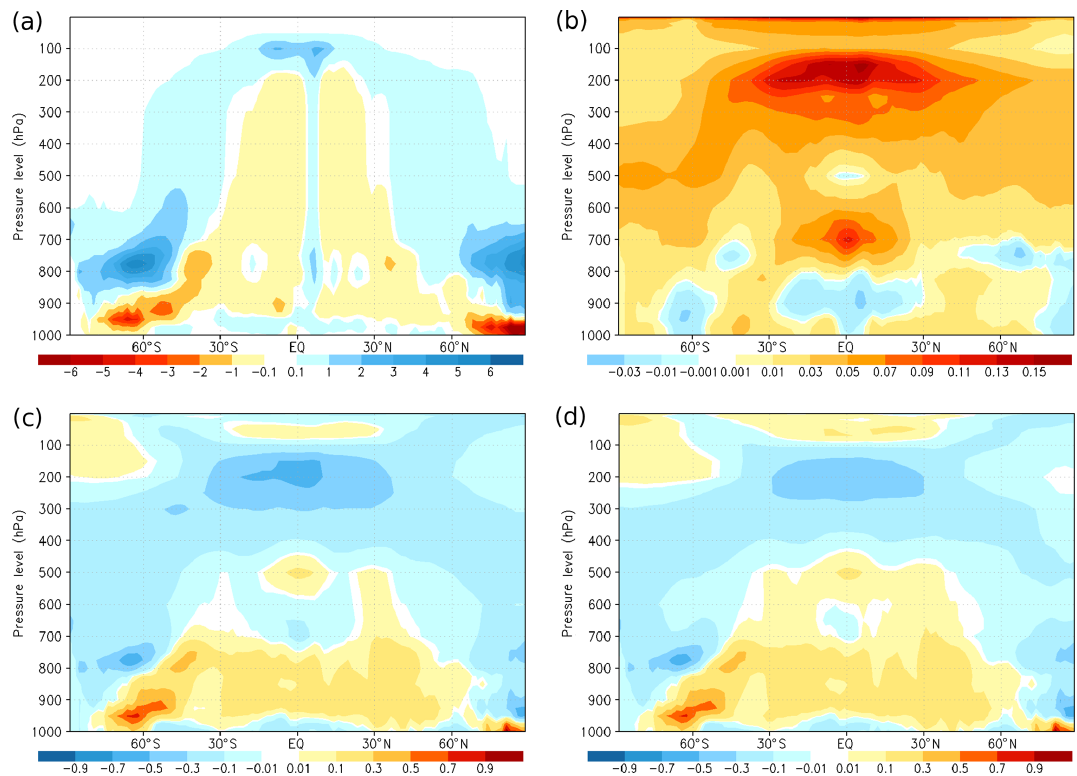
Figure 7. Vertical profiles of the zonal mean of the abrupt4xCO2–piControl mean difference for the following variables: (a) cloud fraction; radiative heating or cooling rate (d T/ d t ; Kd − 1 ) of (b) shortwave, (c) longwave, and the (d) sum of the shortwave and longwave for BESM-